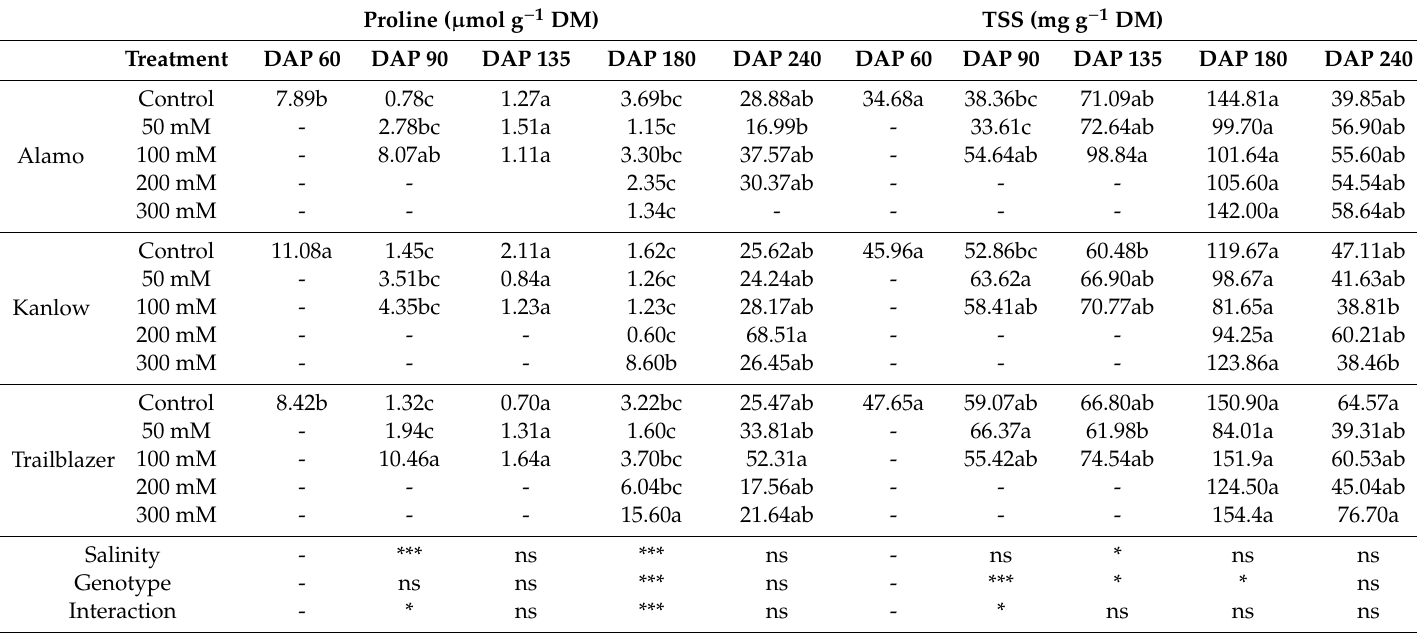
Table 5. The proline and total soluble sugar (TSS) concentrations for the control, 50, 100, 200 and 300 mM NaCl treatments in Alamo, Kanlow and Trailblazer genotypes of Panicum virgatum